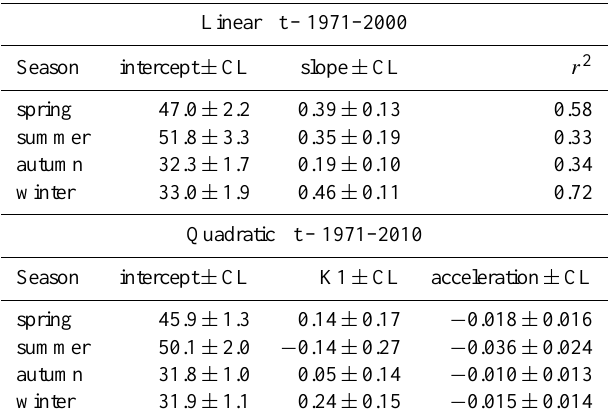
Fig. 2. Seasonal O 3 averages measured at Hohenpeissenberg Ger- many. The solid lines indicate linear regressions for the data up to and including year 2000. The dotted lines give the quadratic regres- sions for the entire data sets.